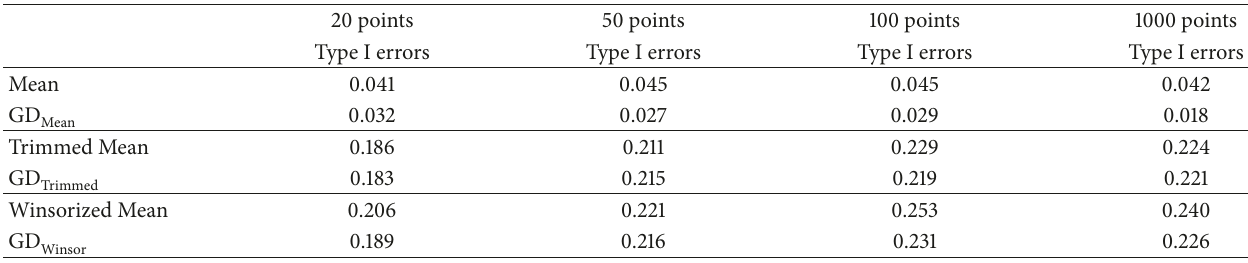
Table 28: Exponential distributions with 30% noise level.